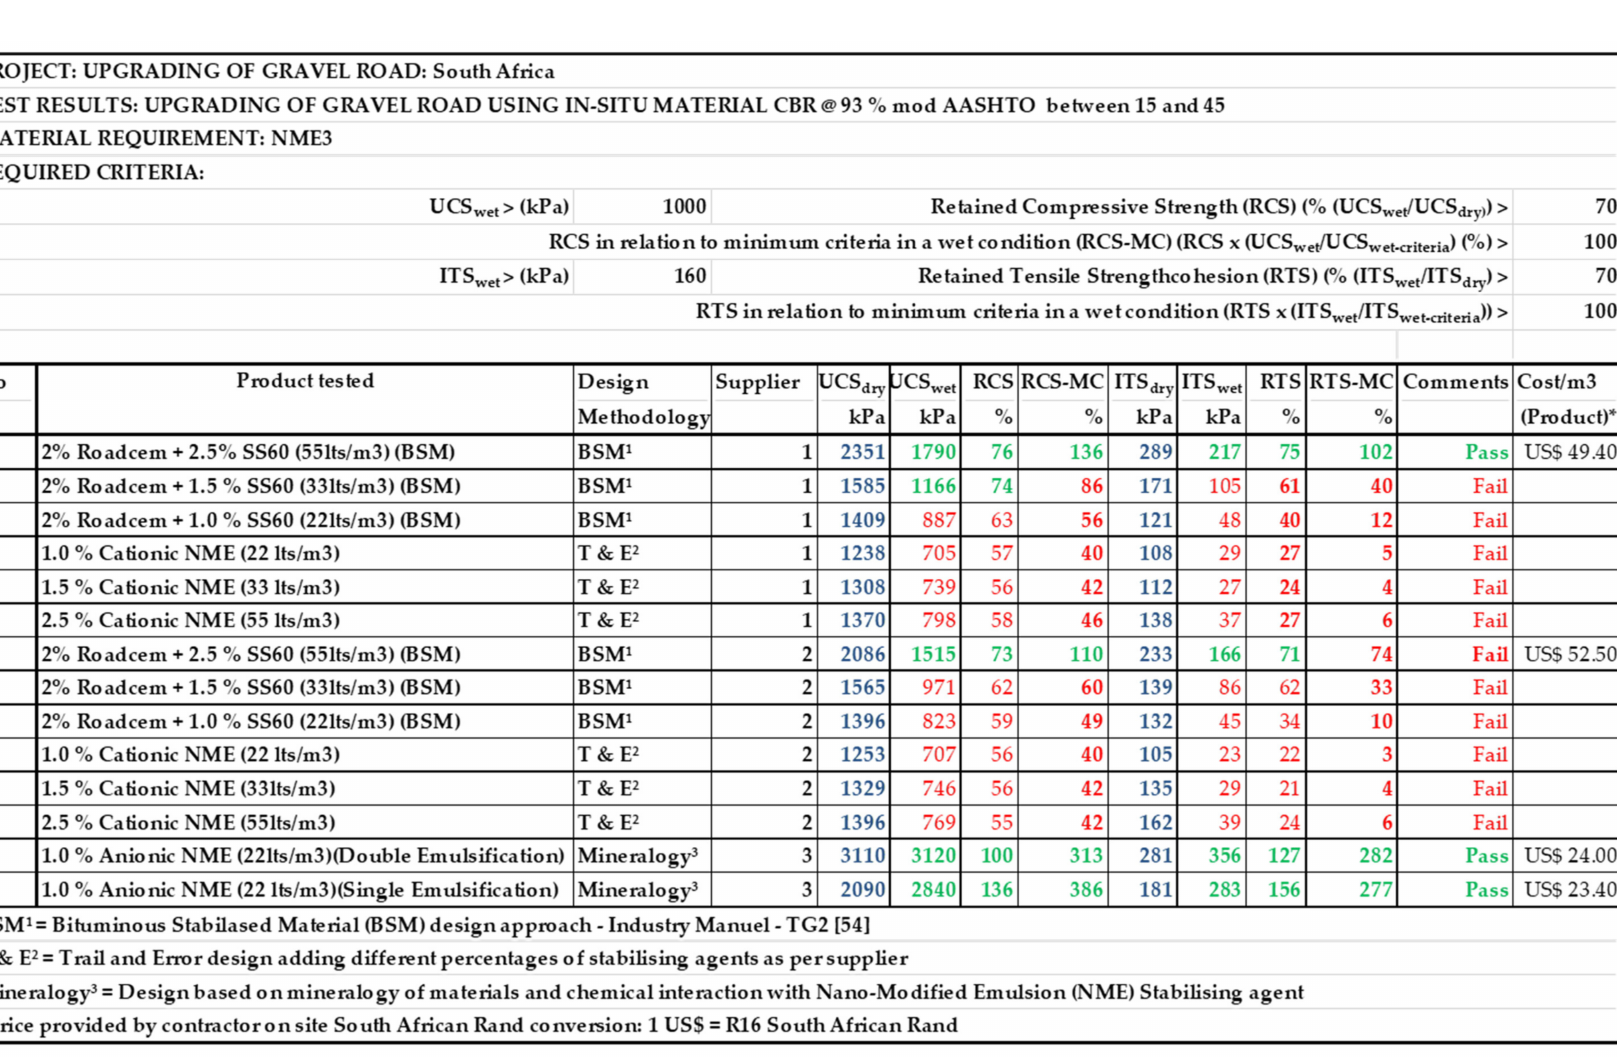
Figure 28. Results of the testing of stabilised materials as per design criteria for an NME3 (Figure 24) layer using different stabilising agents and different design methods/approaches, as detailed at the